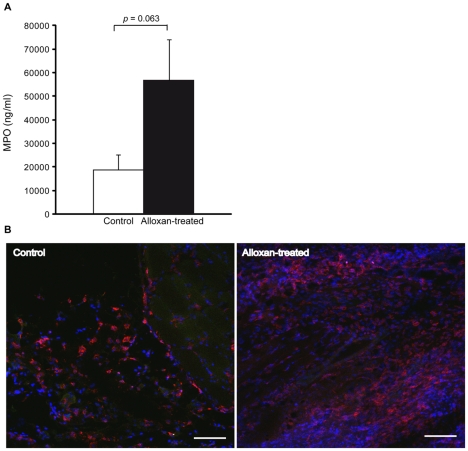
Recruited neutrophils and macrophages to the bacterial infection in control and alloxan-induced diabetic mice.Extravasated neutrophils expressed as concentration of myeloperoxidase (MPO) (A) in the bacteria-infected backs in control (n = 7) and alloxan-treated diabetic (n = 7) mice. Data are means ± SEM. B, Representative images of macrophages (Alexa555-konjugated F4/80 antibody) in bacteria-infected area in control and alloxan-treated mice. Scale bar: 100 µm.